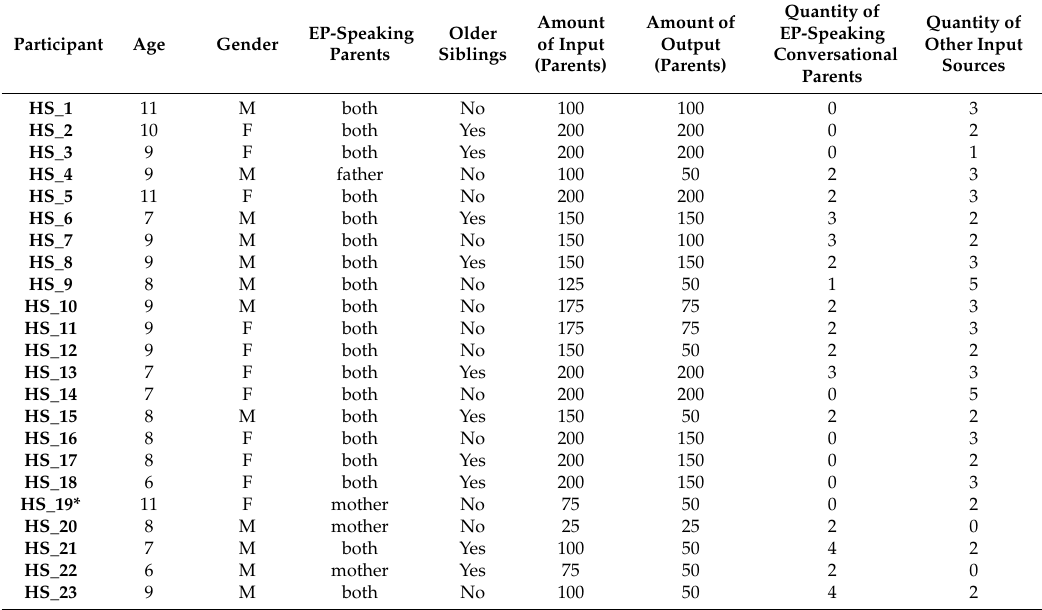
Table A1. Sociolinguistic data of the bilingual